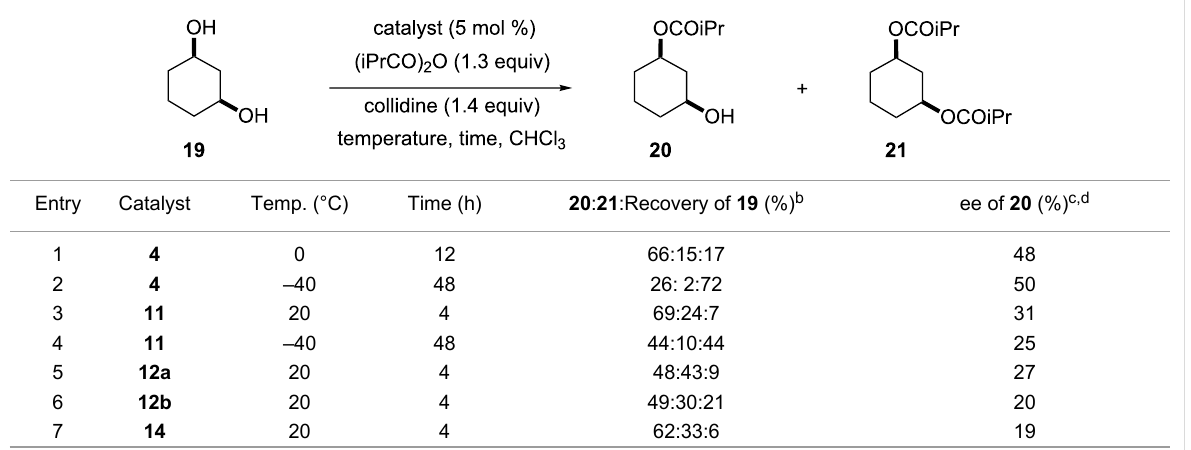
Table 5: The asymmetric desymmetrization of meso -1,3-cyclohexanediol ( 19 ) with C 2 -symmetric chiral PPY catalysts. a